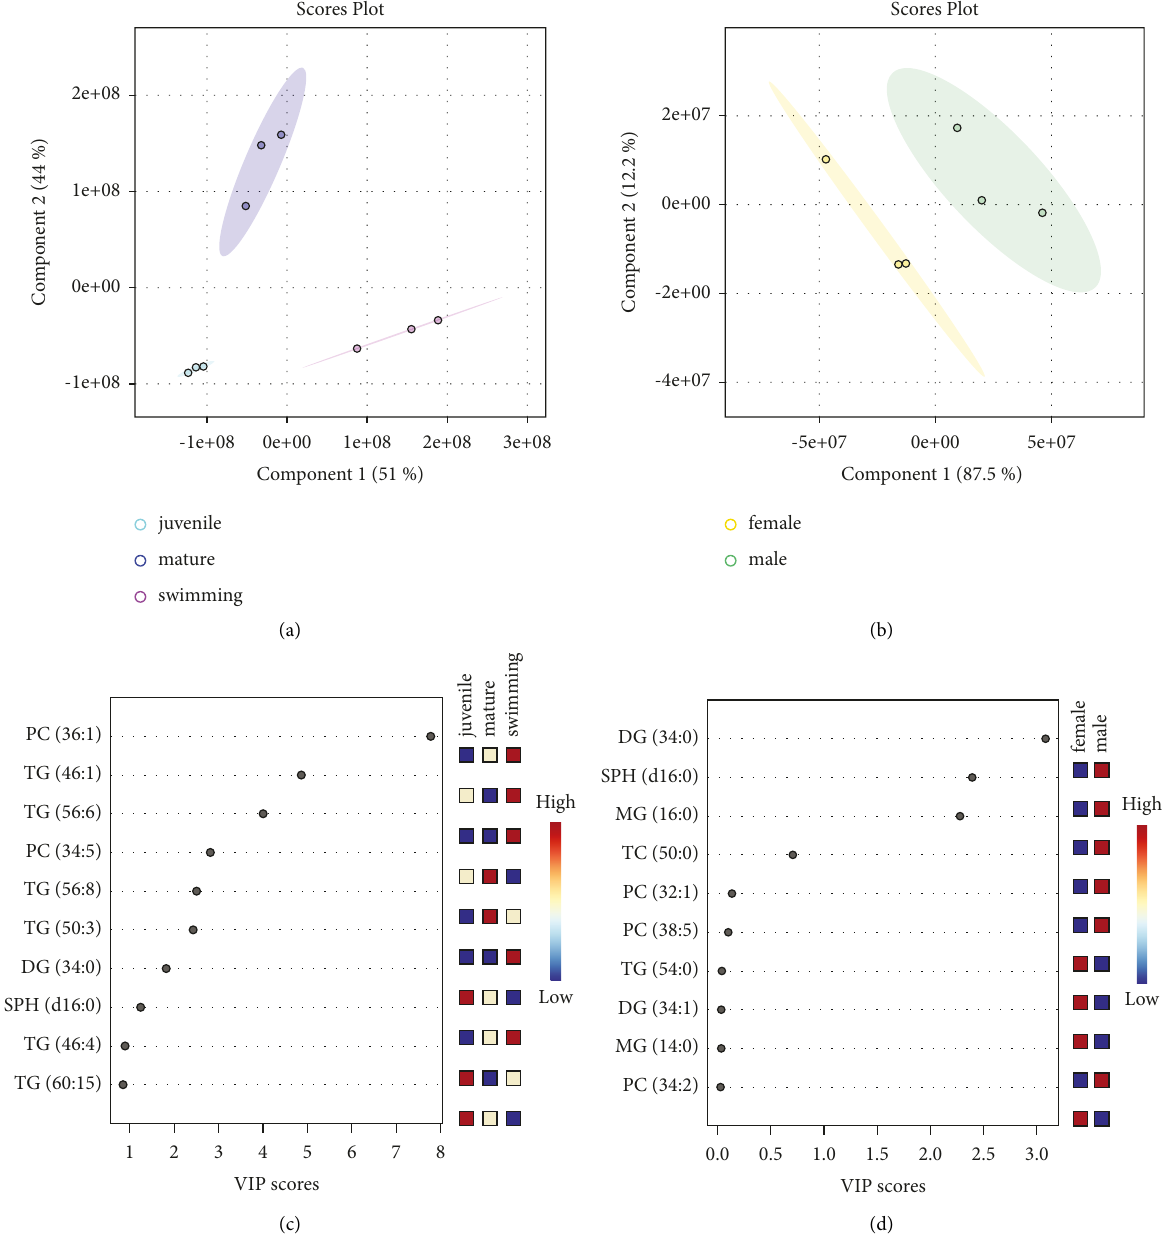
Figure 3: Partial least squares-discriminant analysis (PLS-DA) score plots and variable importance in projection (VIP) score plots displaying the top 10 most important lipids in abalone tissues and hemolymph. (a) PLS-DA score plot of tissues at three different de- velopmental stages. (b) PLS-DA score plot of female and male hemolymph. In the PLS-DA score plots, the colored ellipse represents the 95% confidence interval. (c) Top 10 lipids with the highest VIP scores in tissues at three different developmental stages. (d) Top 10 lipids with the highest VIP scores in female and male